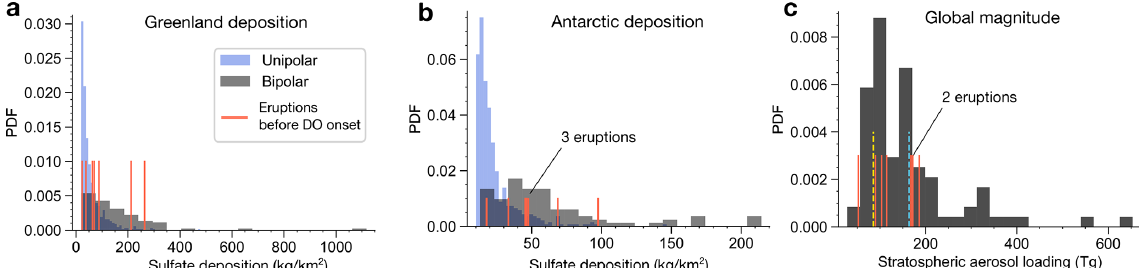
Figure 3. Histograms of the magnitude of volcanic eruptions in the last glacial period according to the LIN22 data sets. (a) The Greenland sulfate deposition of the eruptions is shown for the subset of eruptions classified as bipolar by SVE20, as well as the remaining eruptions identified in the Greenland ice cores during the periods 11.7–16.5ka and 24.5–60ka, which are labeled unipolar hereafter. The deposition level of the seven eruptions that occur within 50 years prior to DO events is given by the red bars. (b) Same for the Antarctic sulfate deposition. (c) Estimated stratospheric aerosol loading of the bipolar eruptions. The yellow and blue dashed lines correspond to the aerosol loading of the 1815CE Tambora and 1257CE Samalas eruptions, respectively (Gao et al., 2007; Sigl et al.,